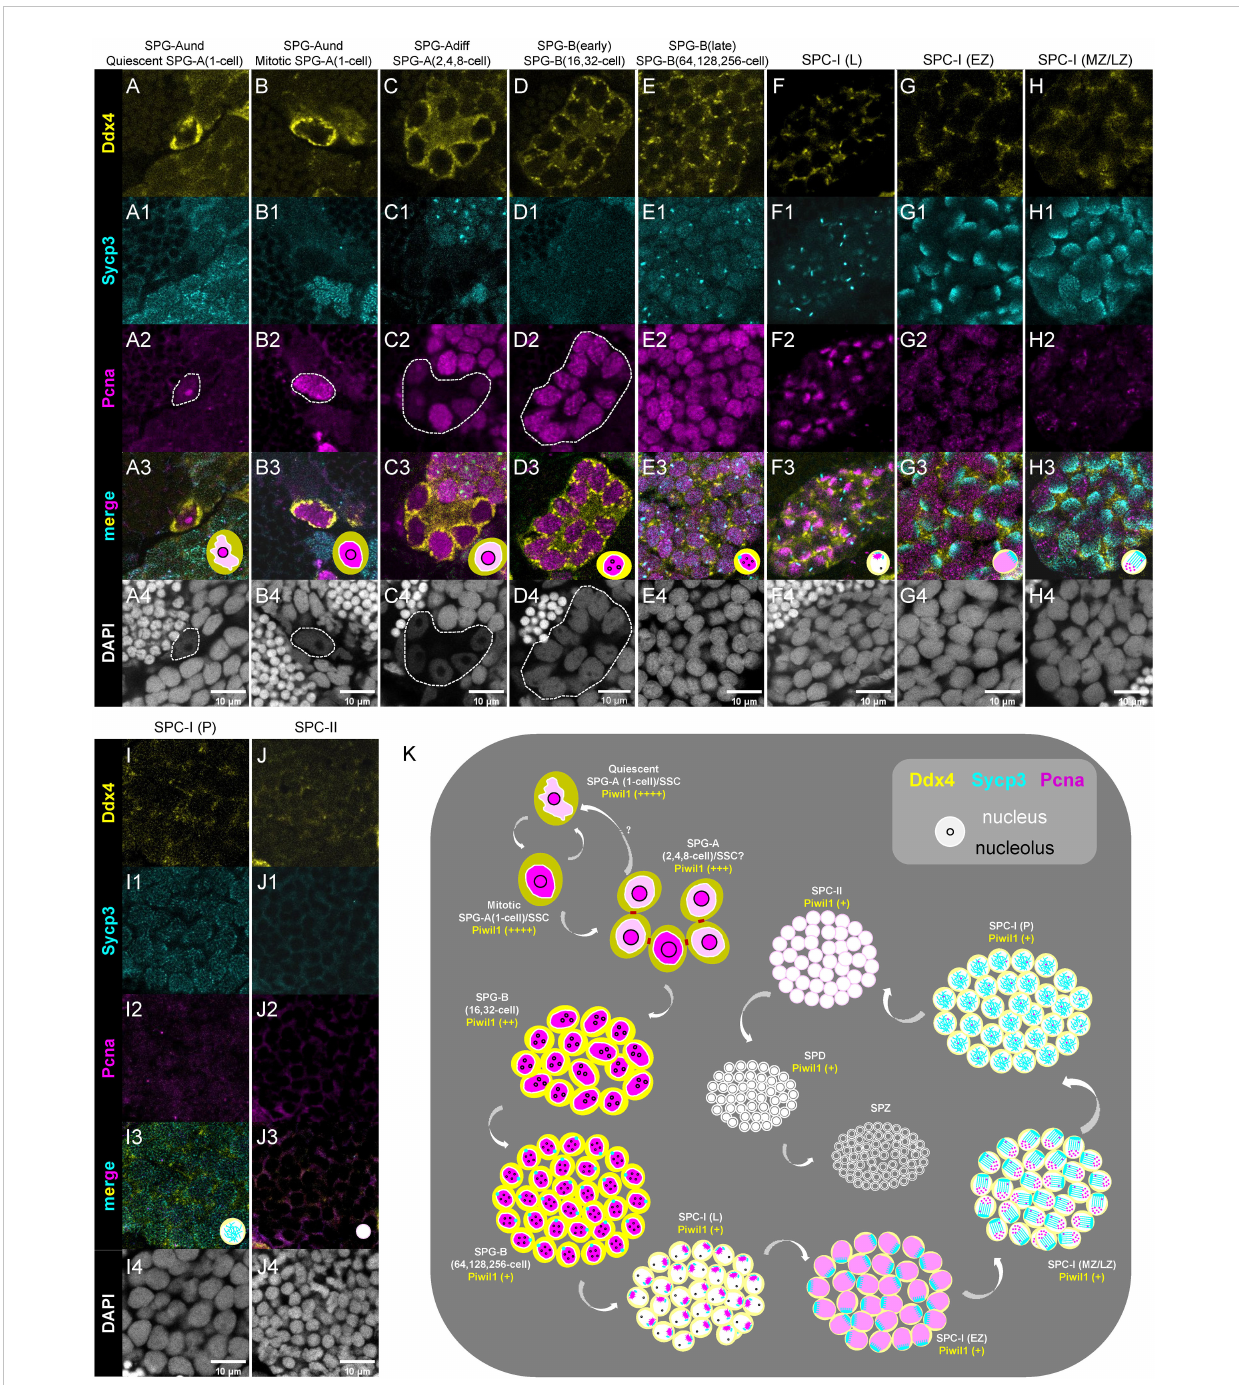
FIGURE 6 Characterization of different types/subtypes of spermatogenic cells by triple-staining of Ddx4, Sycp3 and Pcna. (A-J, A1-J1, A2-J2, A3-J3, A4-J4) The representative images of showing the co-staining of Ddx4 (yellow), Sycp3 (cyan), Pcna (magenta) and DAPI (grey) in the quiescent SPG-A(1-cell) (A-A4) , the miotic SPG-A(1-cell) (B-B4) , the SPG-A(2,4,8-cell) (C-C4) , the SPG-B(16,32-cell) (D-D4) , the SPG-B(64,128,256-cell), the SPC-I (L) (F-F4) , the SPC-I (EZ) (G-G4) , SPC-I (MZ/LZ) (H-H4) , SPC-I (P) (I-I4) , and the SPC-II (J-J4) . Some of the indicated cells are circled by dashed lines to help identifying. (K) A schematic diagram showing the expression of the four proteins in the different types and subtypes of spermatogenic cells. SPG-A (1-cell) can be identi fi ed by the highest expression of Ddx4 and Piwil1. SPG-Bs including SPG-B(16,32-cell) and SPG-B(64,128,256-cell) are identi fi ed by the second highest expression of Ddx4 and the high expression of Pcna, while the later shows nuclear signal of Sycp3. Different subtypes of SPC- I can be identi fi ed by the expression patterns of Sycp3 and Pcna. SPD can be distinguished from SPZ by the expression of Piwil1 or